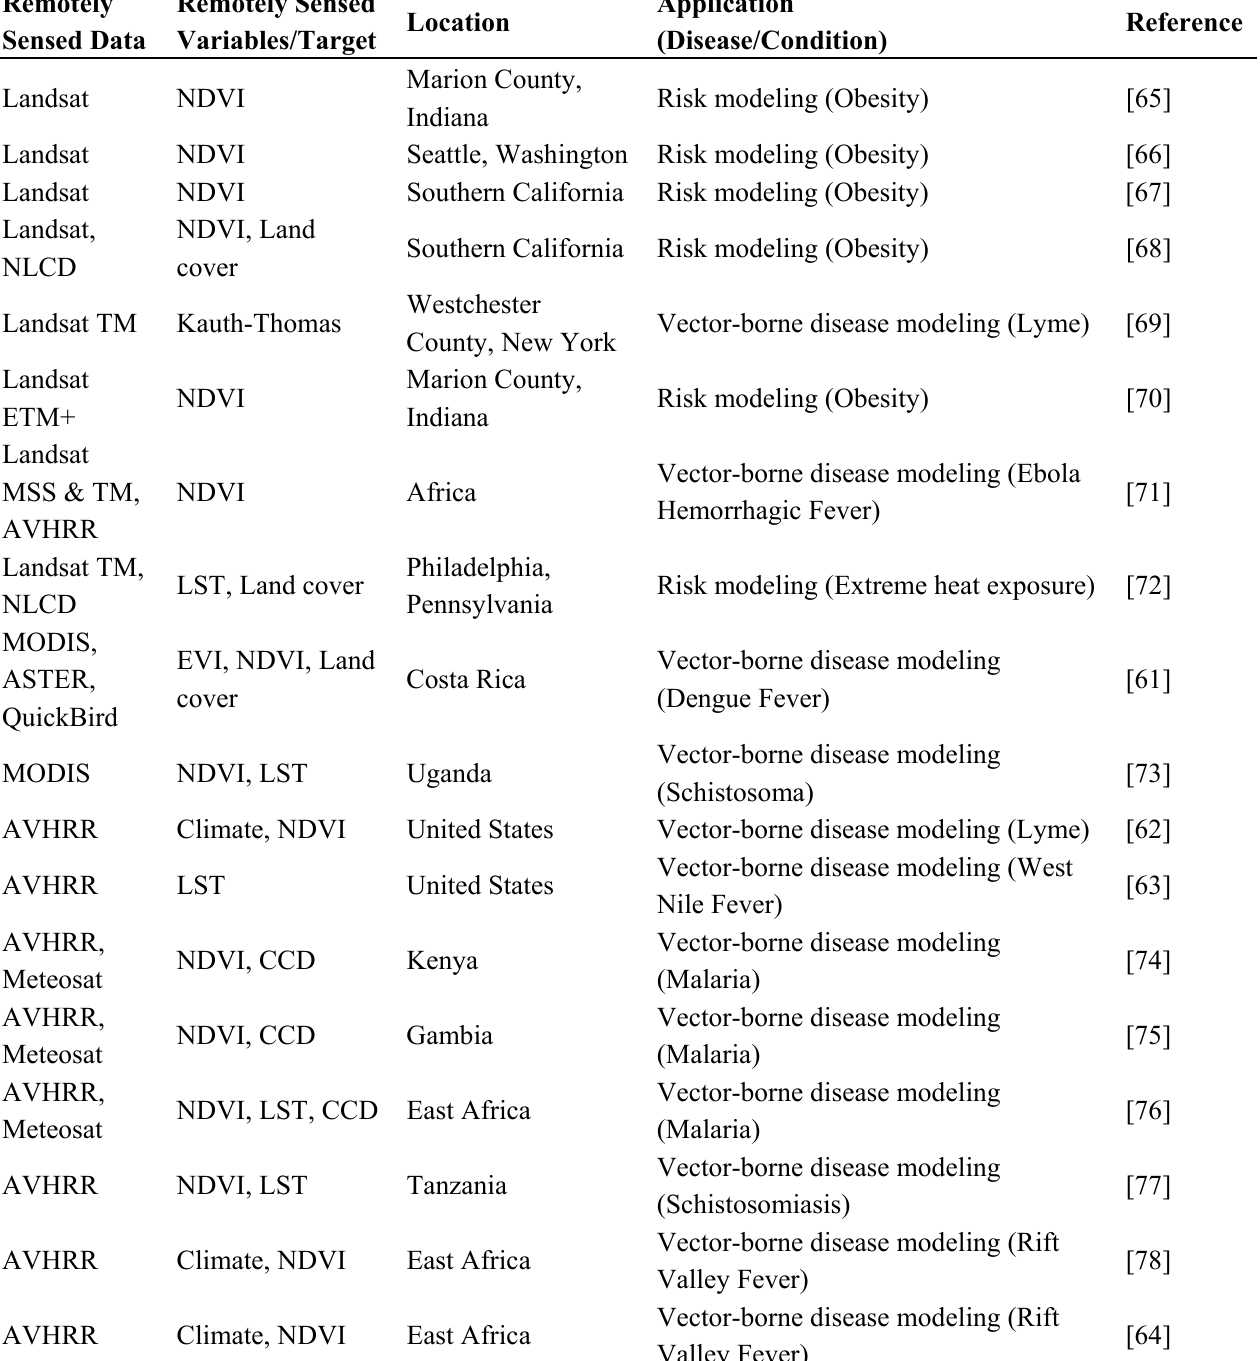
Table 1. Summary of literature in public health using continuous data